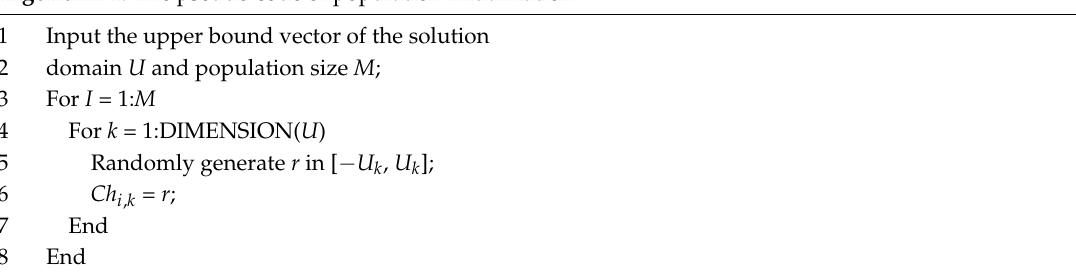
Algorithm 1. The pseudo code of population